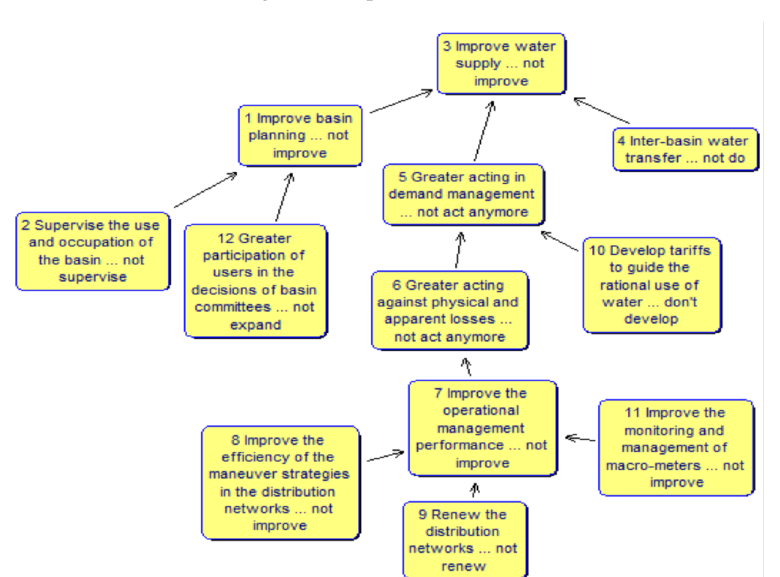
Figure A4. Individual Cognitive Maps of Actor